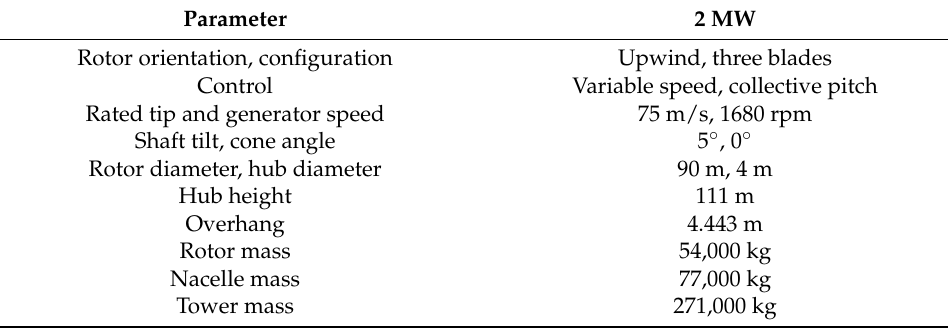
Table 2. Gross properties for the scaled 2 MW wind turbine.